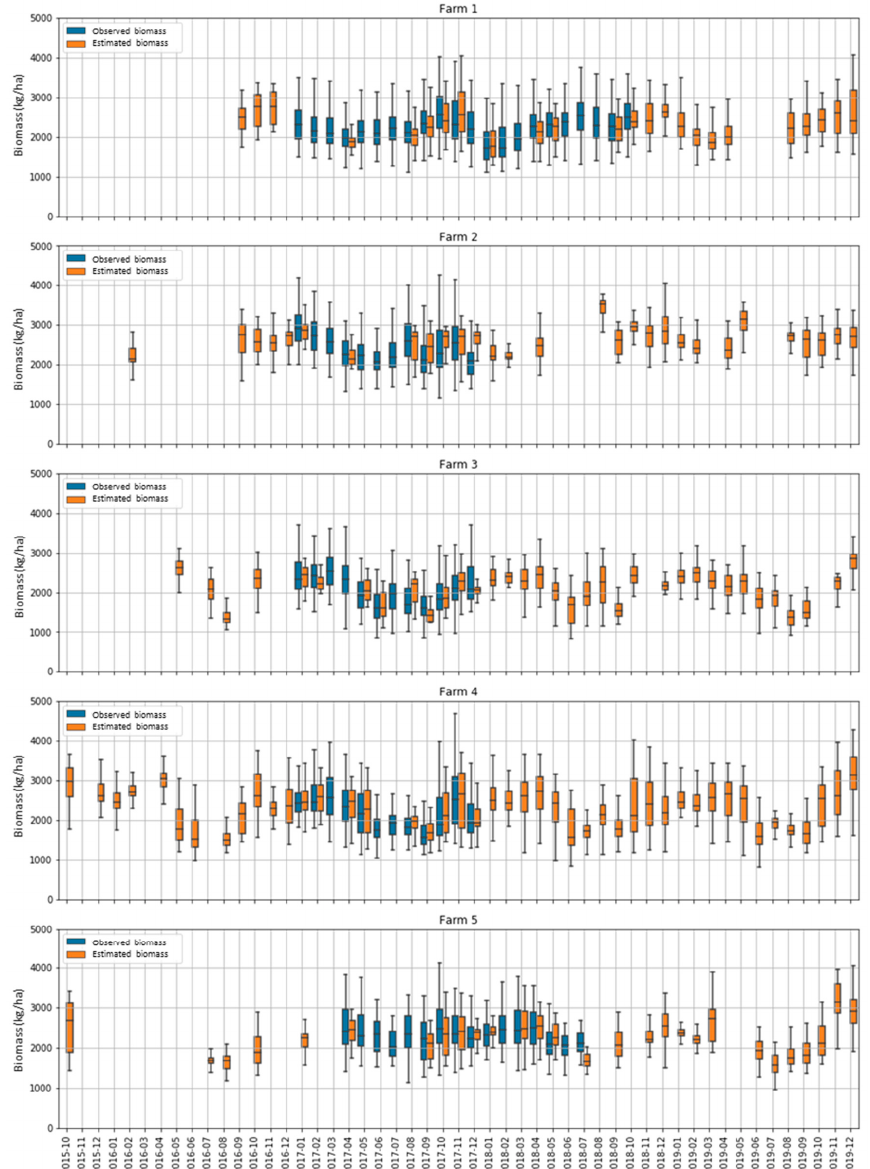
Figure 10. Box plots showing the temporal changes (October 2015–December 2019) of the estimated and observed biomasses in the five farms in each month. Each box plot shows the median, interquartile range (box) and maximum and minimum (whiskers) of all paddocks on the farm in the month.